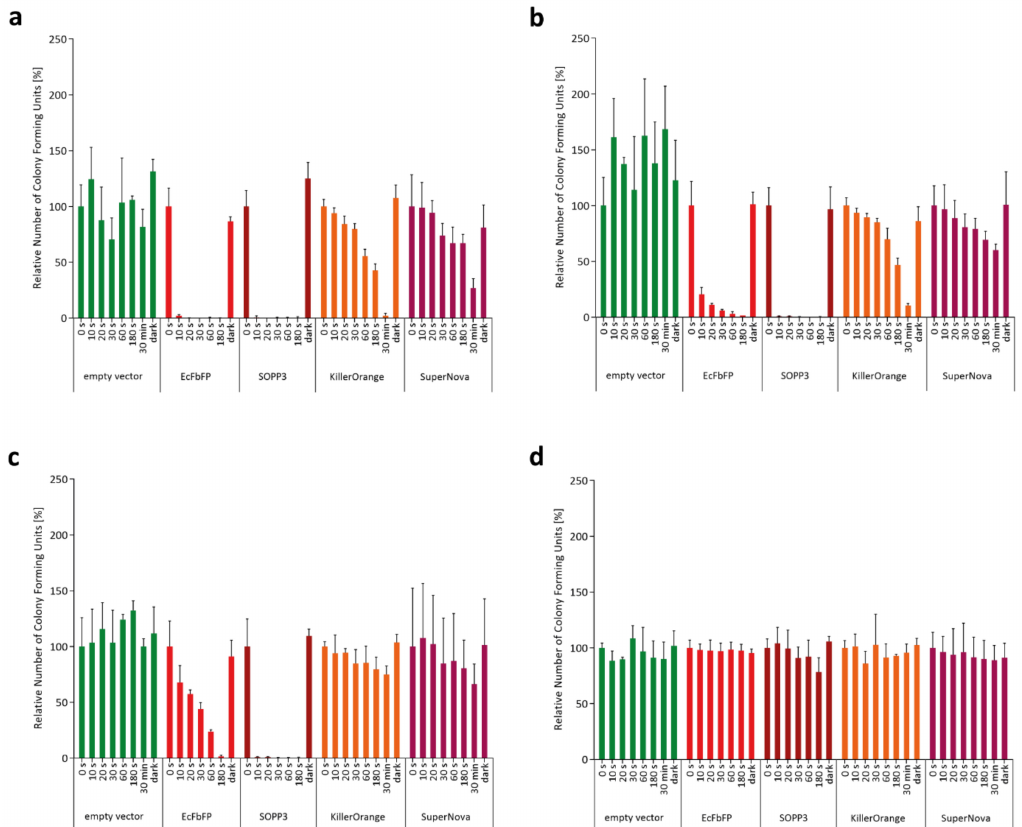
Figure 1. Analysis of colony forming units (CFU) for comparative analysis of in vivo phototoxicity of genetically encoded photosensitizers (PSs). The colony forming capacity of PS-producing E. coli cells was measured in dependence on illumination time and light intensity (( a ) ~130 mW cm − 2 ; ( b ) ~90 mW cm − 2 ; ( c ) ~10 mW cm − 2 ; and ( d ) ~1 mW cm − 2 ). For this, cultures of E. coli BL21(DE3) cells harboring the respective expression vectors were diluted to a finale OD 580 nm of 0.1 in 1x PBS bu ff er (pH 7.4) and then illuminated with blue light ( λ max = 450 nm) and, in the case of SuperNova, with orange light ( λ max = 600 nm). As a control experiment, E. coli cells harboring an empty vector were also illuminated with blue light using the four light intensities. After given time points (0 to 30 min), aliquots of the irradiated cells were transferred to Lysogeny Broth (LB) agar plates and incubated overnight at 37 ◦ C in the dark. Decrease of CFUs represents the time-dependent e ffi cacy of the genetically encoded PSs. Data represent mean values of three independent experiments and their corresponding standard deviations indicated by error